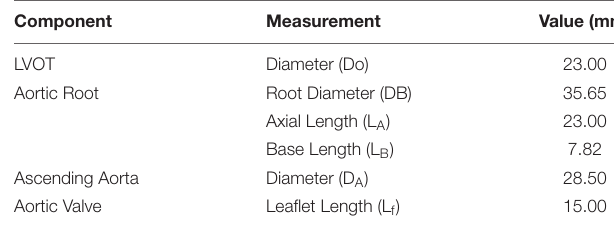
TABLE 1 | Important dimensions in our aorta and aortic valve